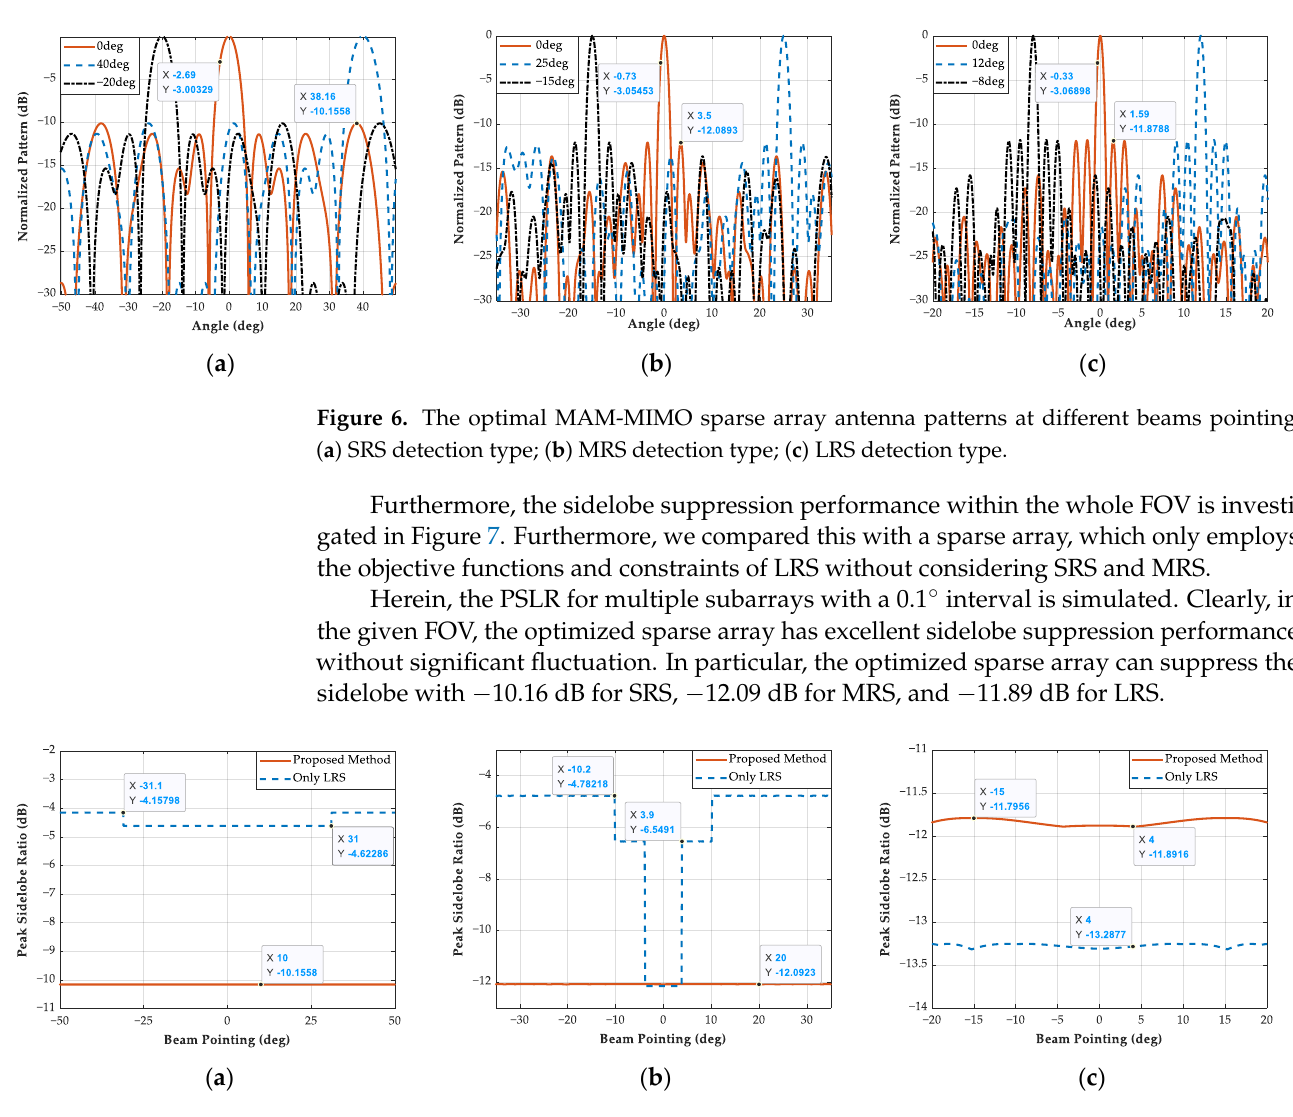
Figure 7. The PSLR of the optimal MAM-MIMO sparse array and only LRS method in the given FOV: ( a ) SRS detection type; ( b ) MRS detection type; ( c ) LRS detection type.